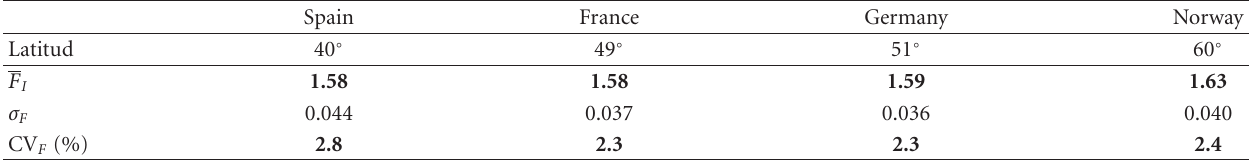
Table 2: Cell current factor mean ( F I ), standard deviation ( σ F ), and coe ffi cient of variation (CV F ).